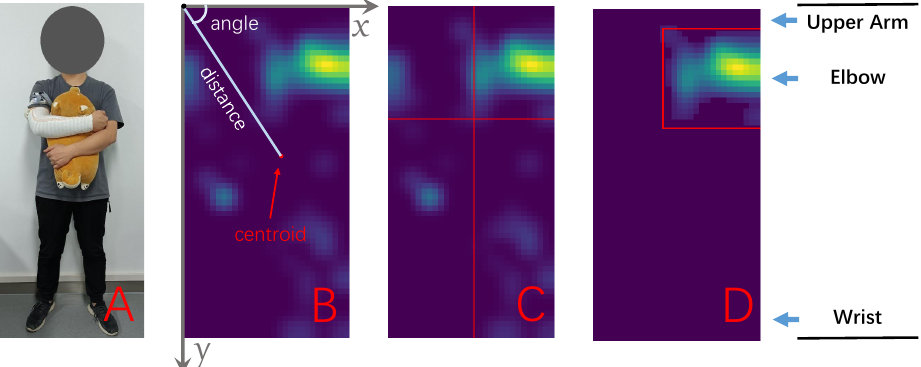
Figure 5. Geometric features calculation. ( A ) Activity 7 (hug a doll), corresponding to the pres- sure image. ( B ) The coordinates ( Feat 9 , Feat 10 ), the distance from the origin ( Feat 13 ), and the an- gle ( Feat 15 ) of the centroid. ( C ) Coverage by regions ( Feat 33 to Feat 36 ). ( D ) The masked image and the bounding